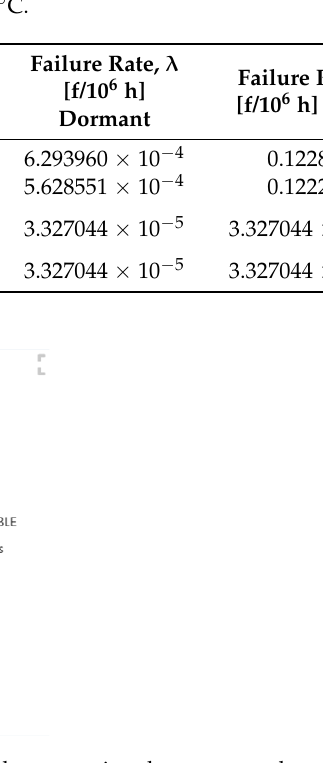
Figure 5. Failure rate percentage of each individual module composing the sensor node structure.